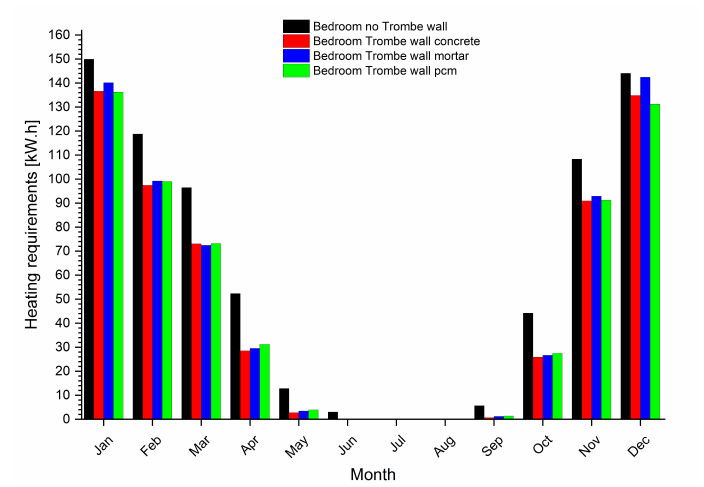
Figure 21. Comparison of monthly heating energy demands in the bedroom.